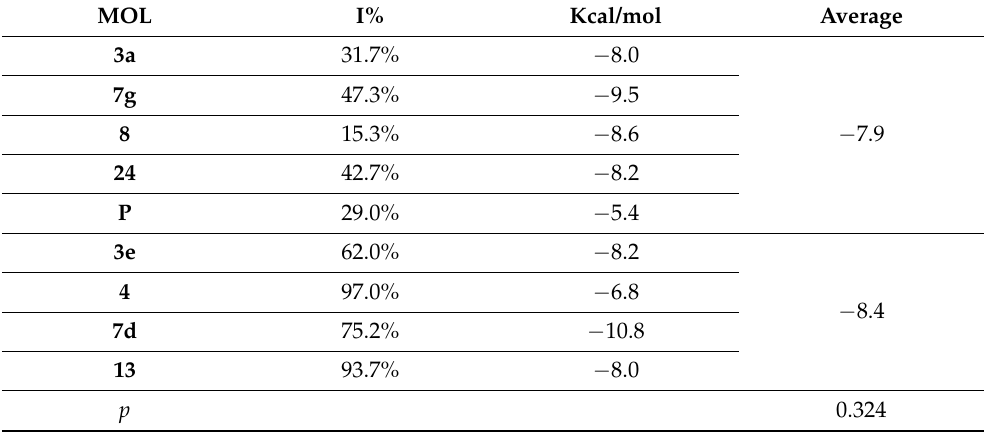
Table 5. Binding energy from Autodock.